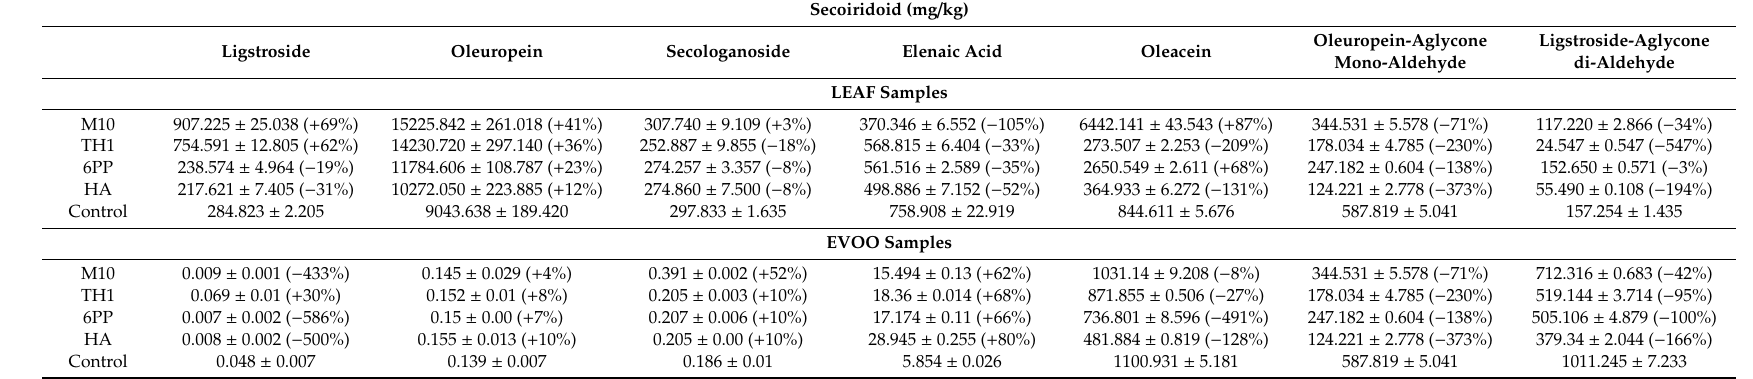
Table 6. Secoiridoids in the leaf and the EVOO